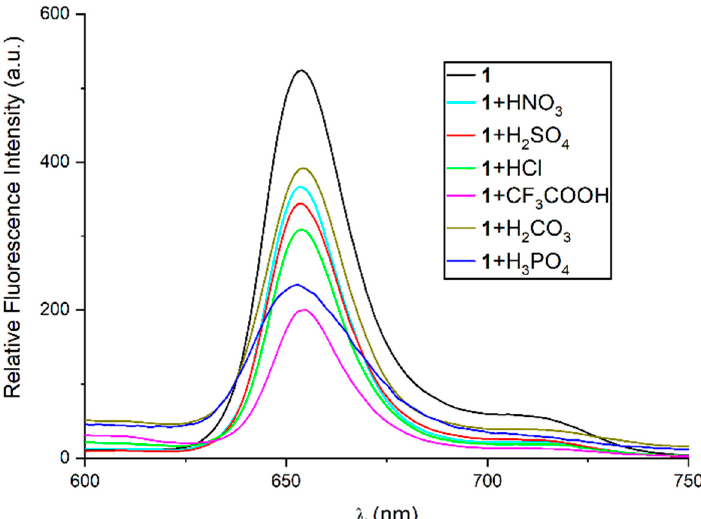
Figure 3. Fluorescence spectra of compound 1 and its different ionic complexes in CHCl 3 . Optical density (OD) of the sample solution was fixed at 0.20.